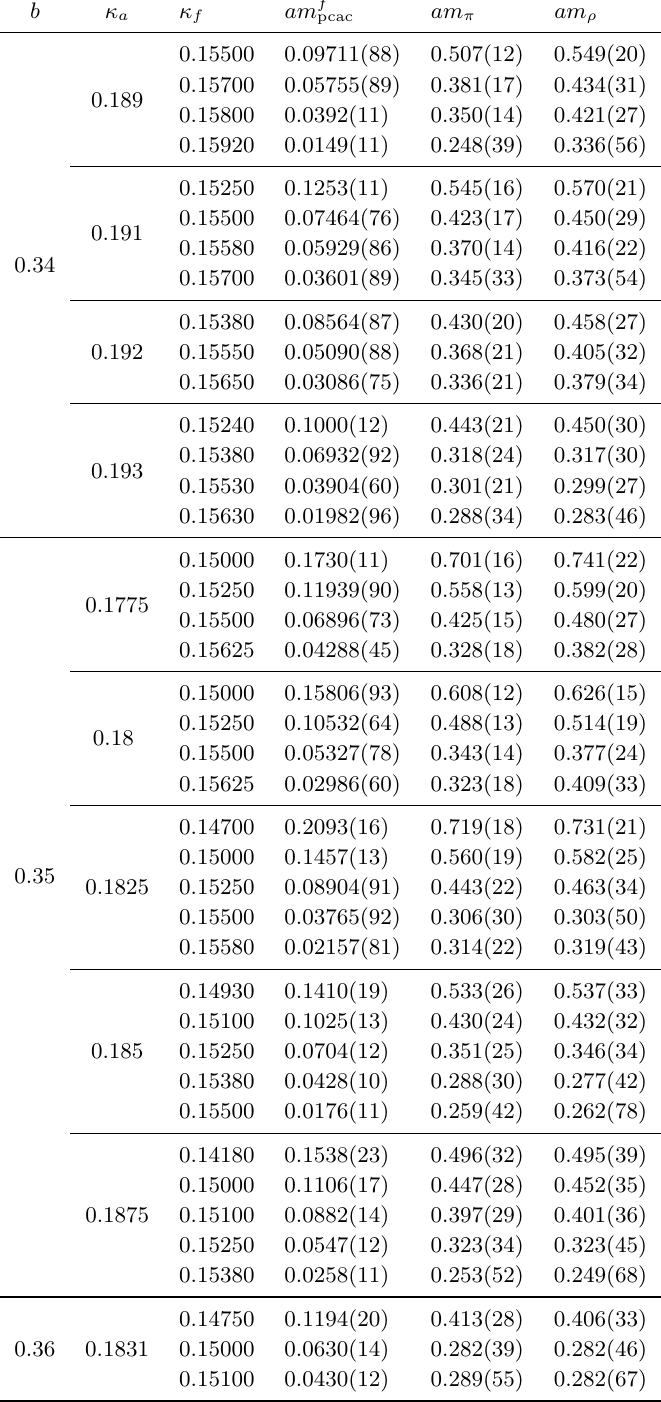
Table 4. The values of m f , m π and m ρ for fermions in the fundamental representation and pcac for each ( b, κ a , κ f ) value at N = 289 are given. The fitting procedure is the one described in section 6.3.1, from which we obtained χ 2 per degrees of freedom in general smaller than